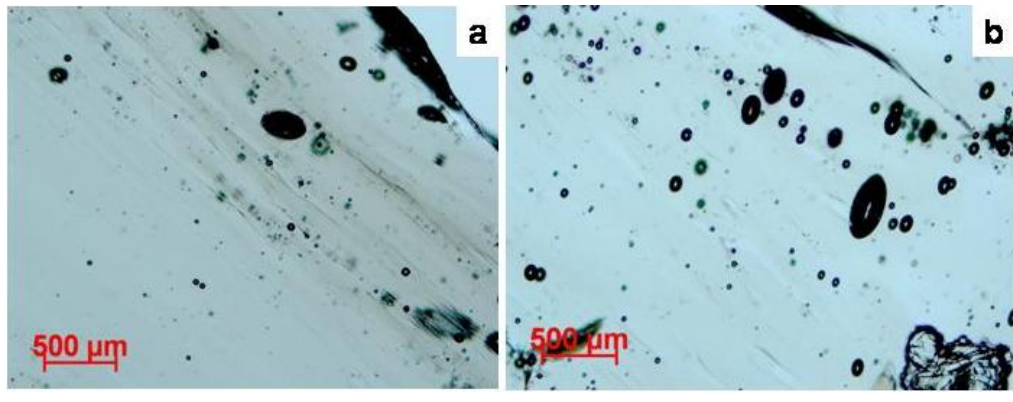
Figure 10. Optical images showing the elongated shape of the pores in sample ( a ) No. 7 and ( b ) No. 23. The pore elongation clearly differs from the flow lines (oriented